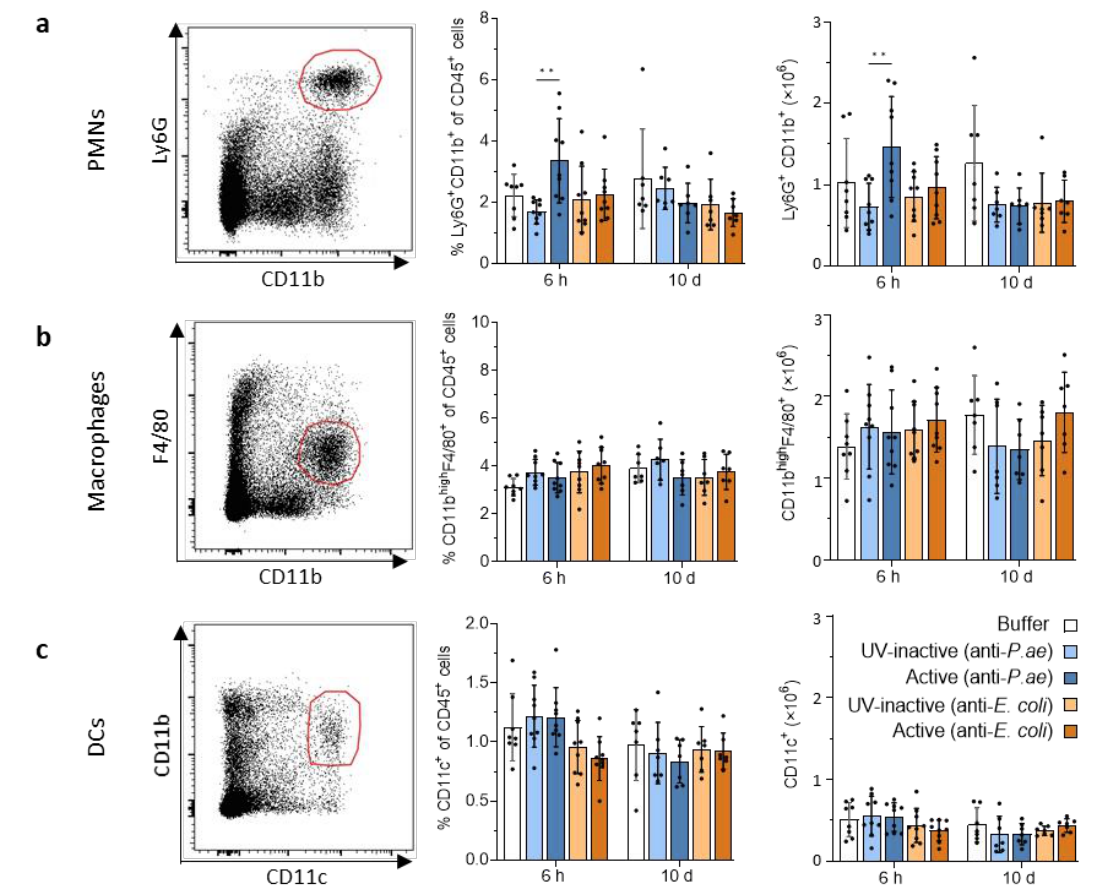
Figure 3. No changes in splenic innate immune cell frequencies and numbers in response to phage cocktail treatment observed. Flow cytometric analysis of ( a ) PMNs, ( b ) macrophages and ( c ) DCs in the spleen. Shown are representative dot plots (left), and bar graphs depicting the percentage of remaining cells (middle) or total cells (right). Results are shown as mean ± SD, as determined by 2- way ANOVA with Tukey ’ s multiple comparisons test: ** p < 0.01; n = 7 – 9 mice per group. For full gating strategy and cell type identifying markers see Figure S1. PMNs, polymorphonuclear neutrophils; DCs, dendritic cells.